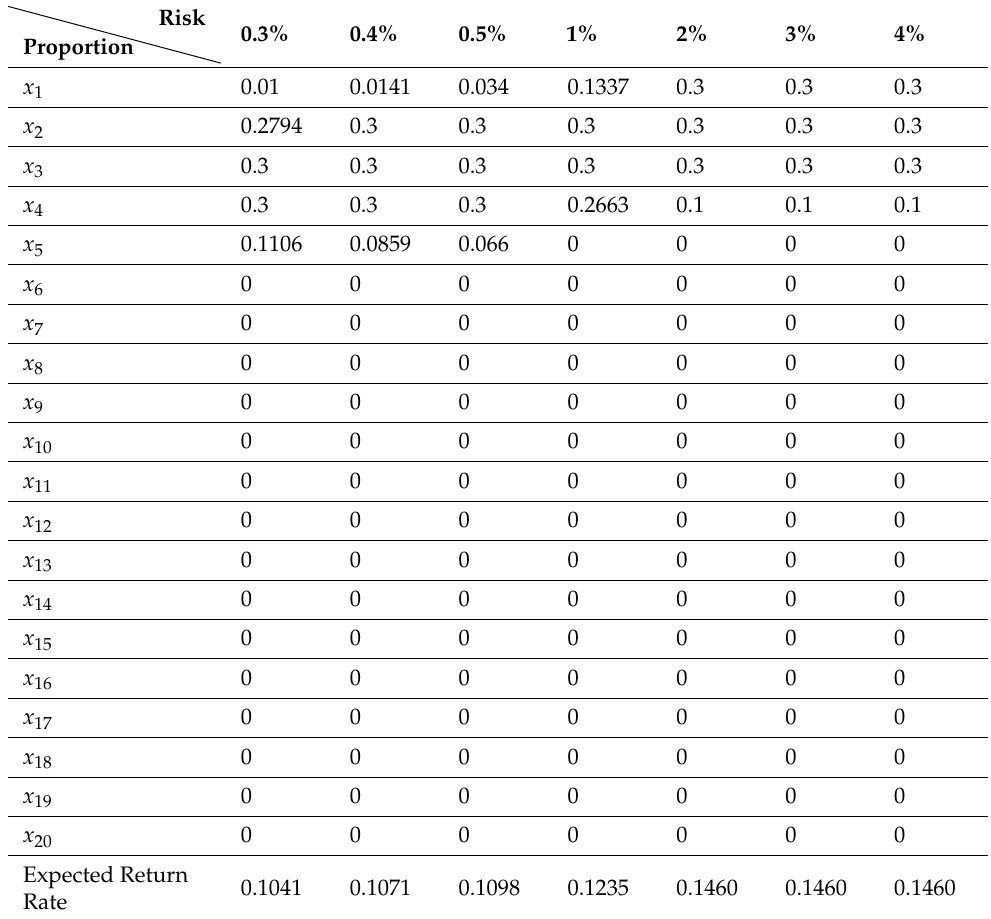
Table 8. The efficient portfolio with the guaranteed return rate (cid:101) p 3